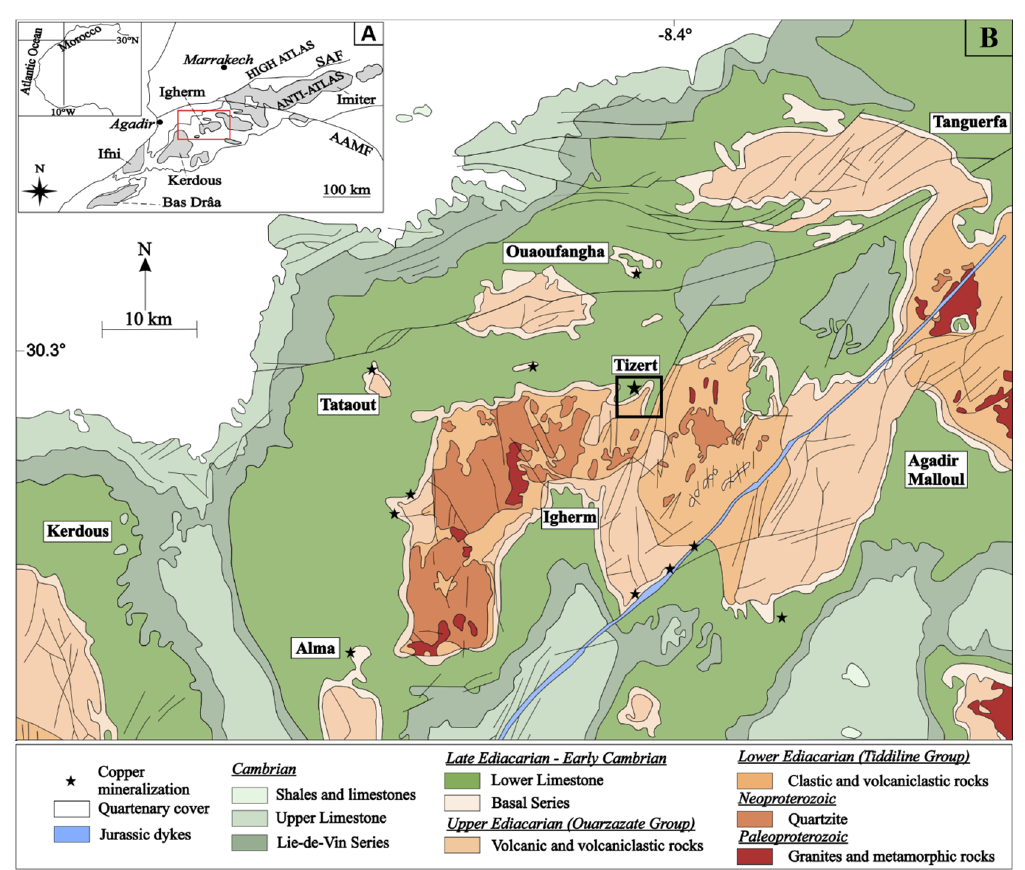
Figure 1. ( a ) General map of the Anti-Atlas; ( b ) Simplified geological map of the Igherm inlier (black Figure 1. ( A ) General map of the Anti-Atlas; ( B ) Simplified geological map of the Igherm inlier (black square shows Tizert aera) (Modified after reference [4]). square shows Tizert aera) (Modified after reference